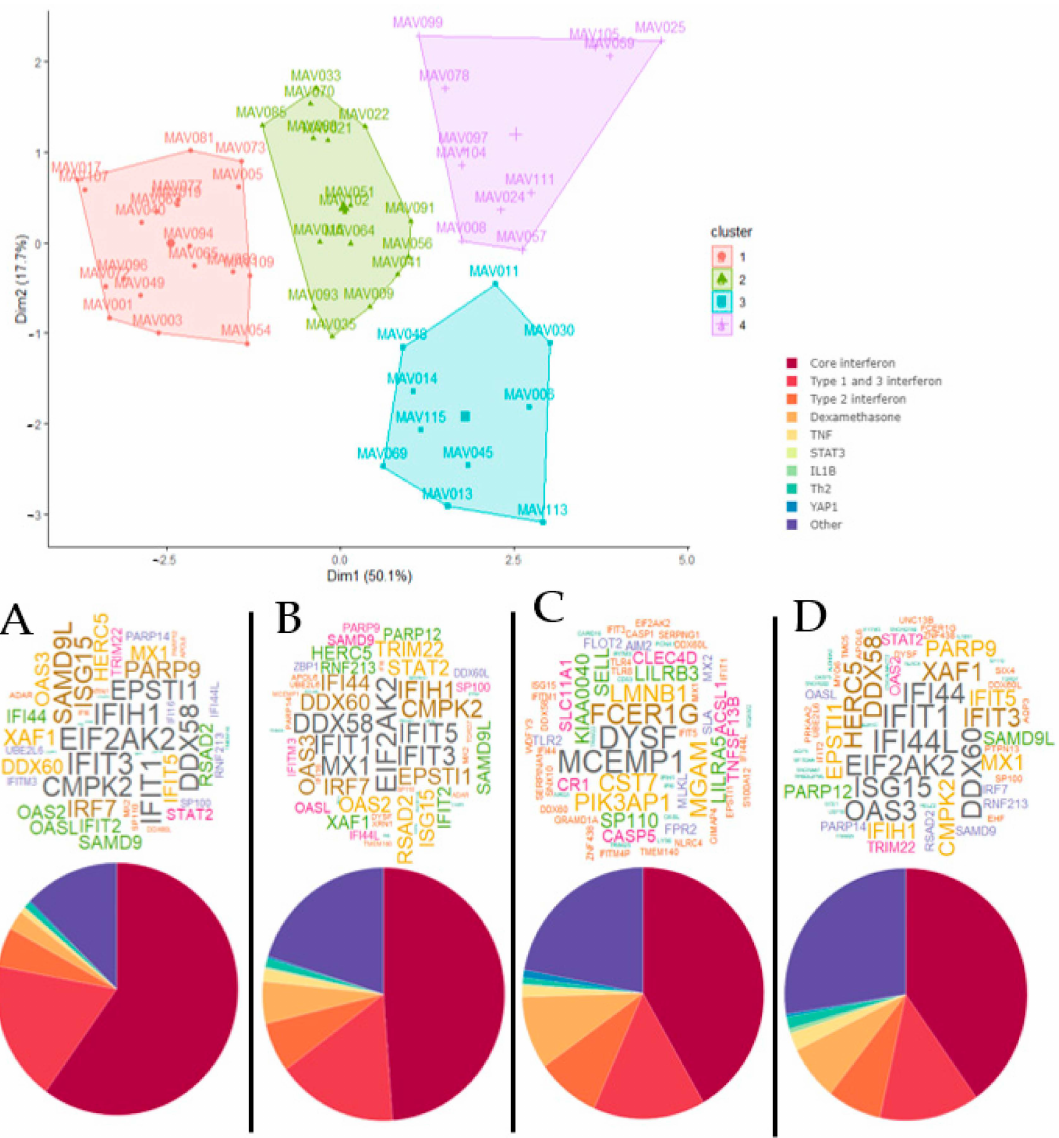
Figure 2. Cluster analysis of personal gene network patterns unveils molecular subtypes of acute wheezing. FactoMineR cluster plot, word cloud plots of the top 20 hub genes for each individual case ( top ) and averaged personal gene network pathway proportions ( bottom ) for clusters A, B, C and D. Word color and size indicates